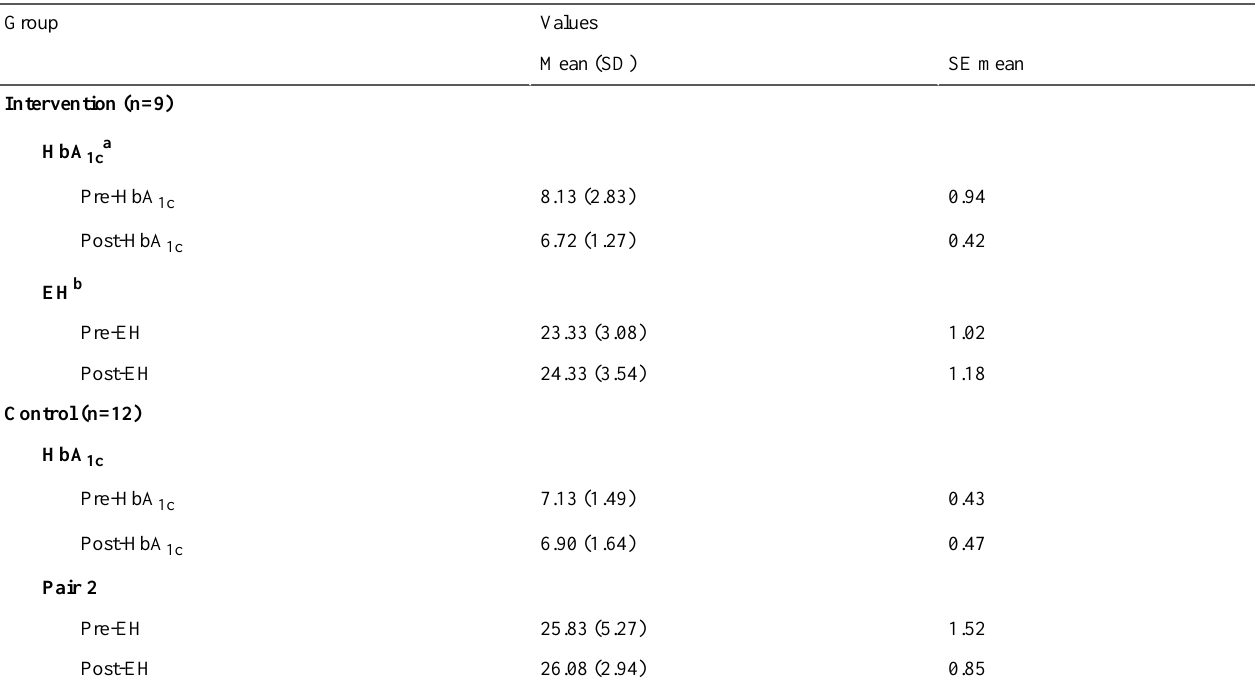
Table 2. Descriptive statistics on the eating habits composite score and glycated hemoglobin before and after the experiment.